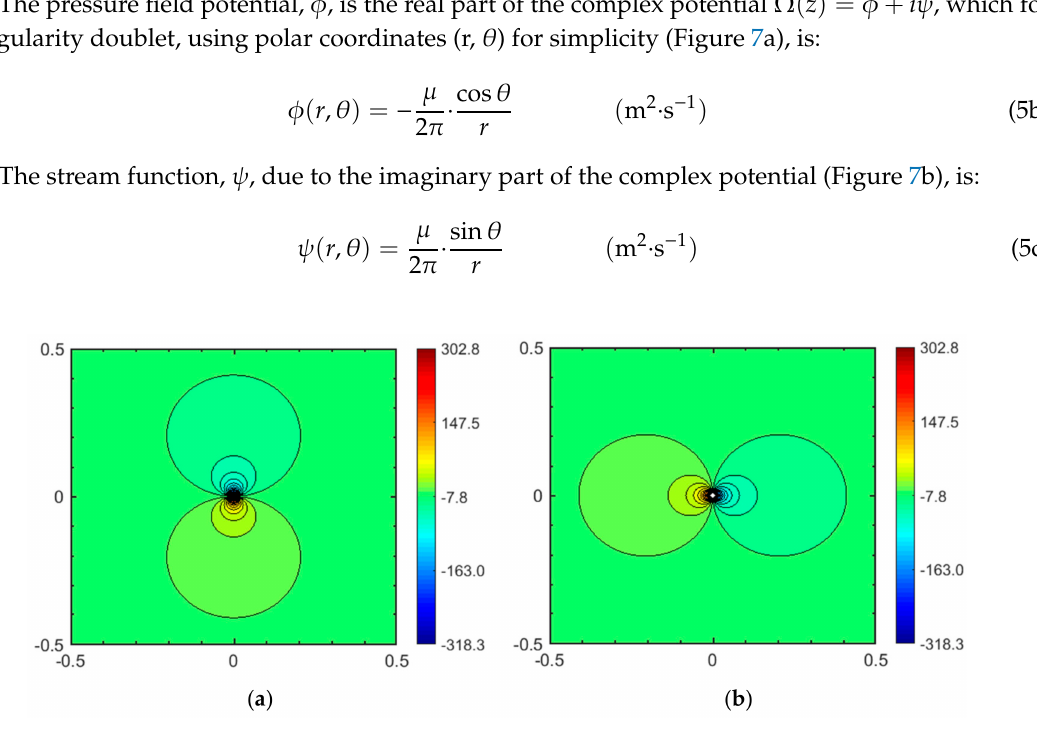
Figure 7. Point (singularity) doublet (Figure 5b). ( a ) Potential function values ( Φ ) given by concentric circles (m 2 · s − 1 ) relative to line y = 0 and ( b ) Stream function values ( Ψ ) given by concentric circles (m 2 · s − 1 ). The highest and the lowest values lie close to the singularity and quickly subsides. Strength of point doublet ( µ ) = 20 m 3 · s − 1 and z d =